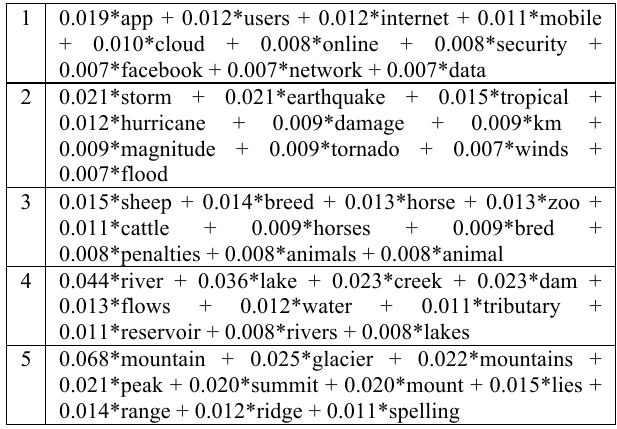
Table 1. Five topics generated from LDA